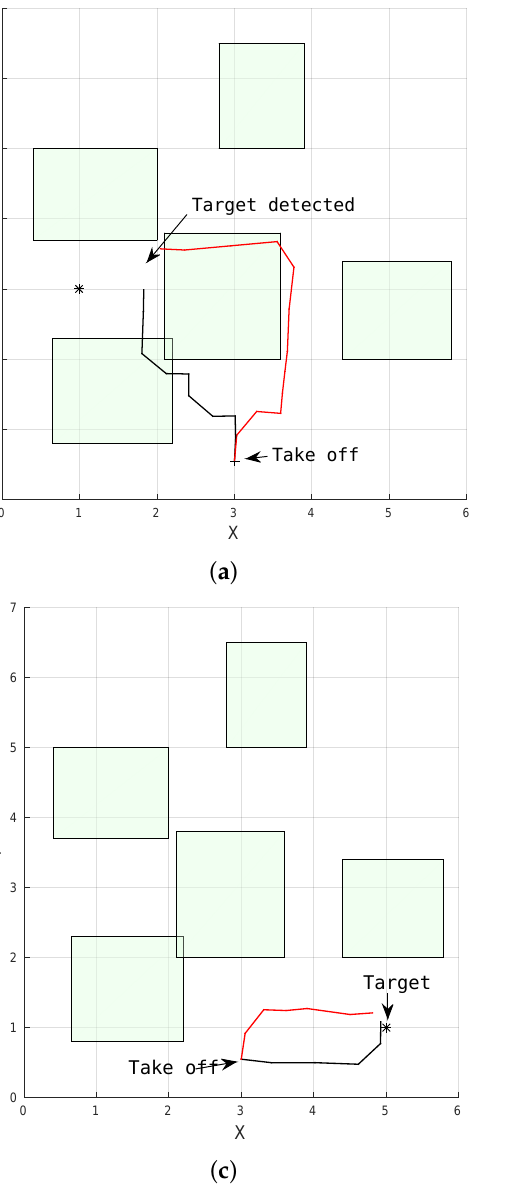
Figure 7. Example of trajectories to four different target locations produced by ABT (black) and POMCP (red) in simulation. ( a ) Target located at (1.0, 3.0, 0.15); ( b ) target located at (1.0, 6.5, 0.15); ( c ) target located at (5.0, 1.0, 0.15); ( d ) target located at (5.0, 6.0,